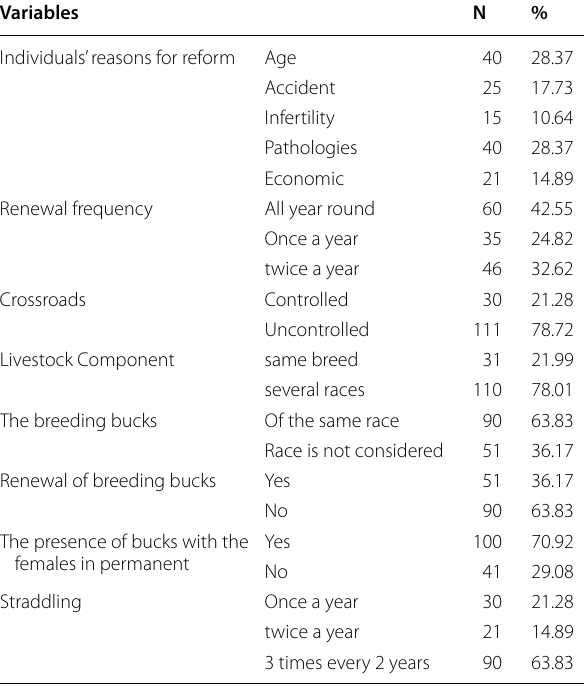
Table 4 Management of goat reproduction in the different study areas